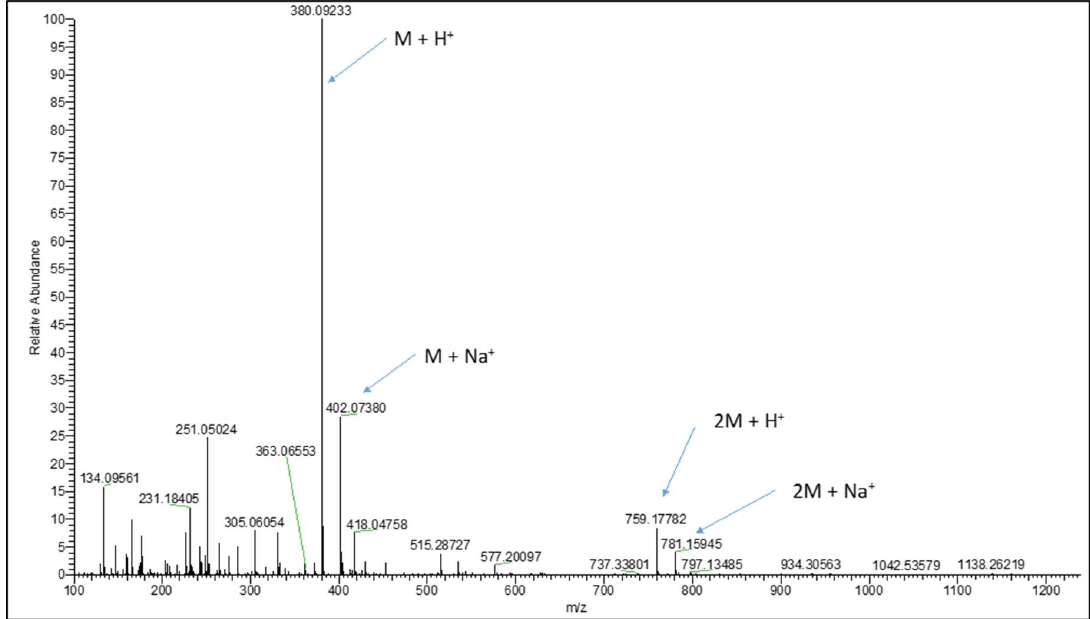
Figure 1. LC-MS (ESI) of S -allylmercaptoglutathione (GSSA) synthesized by reacting glutathione (GSH) with allicin.